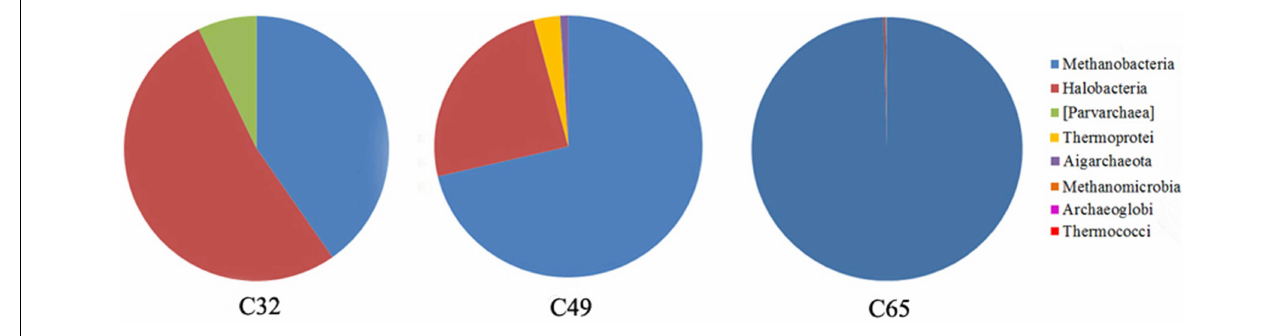
The C32 sample is dominated by halophiles, followed by methanogens and the proposed lineage [Parvarchaea]. As the temperatures increases, the dominance shifts toward methanogens (sample C49 and